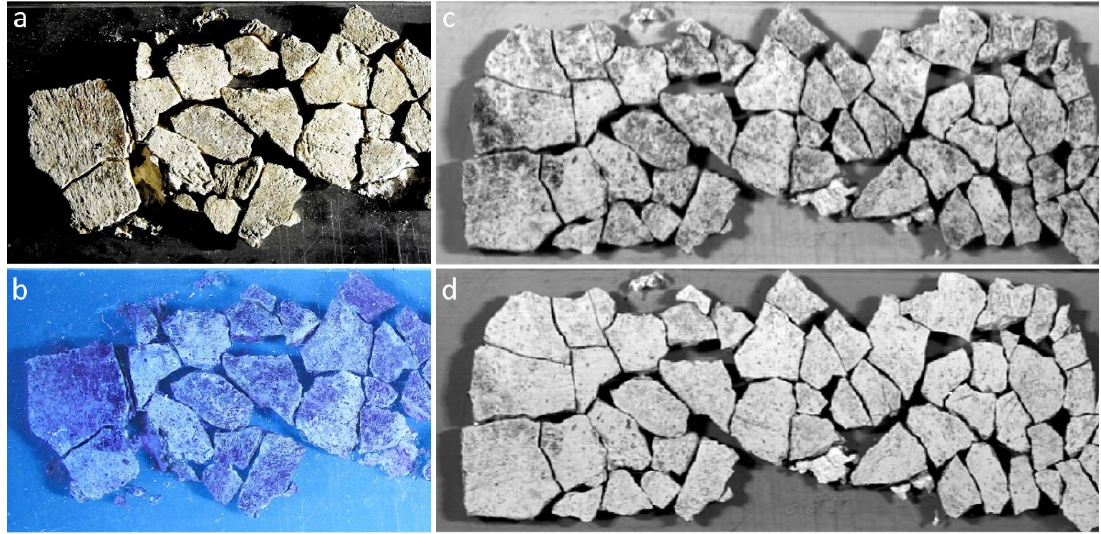
Figure 8. Details in raking light ( a ) and under UV fluorescence examination ( b ). Hyperspectral imaging details that highlight the behavior of the pigments at specific wavelength values: 954 nm ( c ); 1600 nm ( d ).